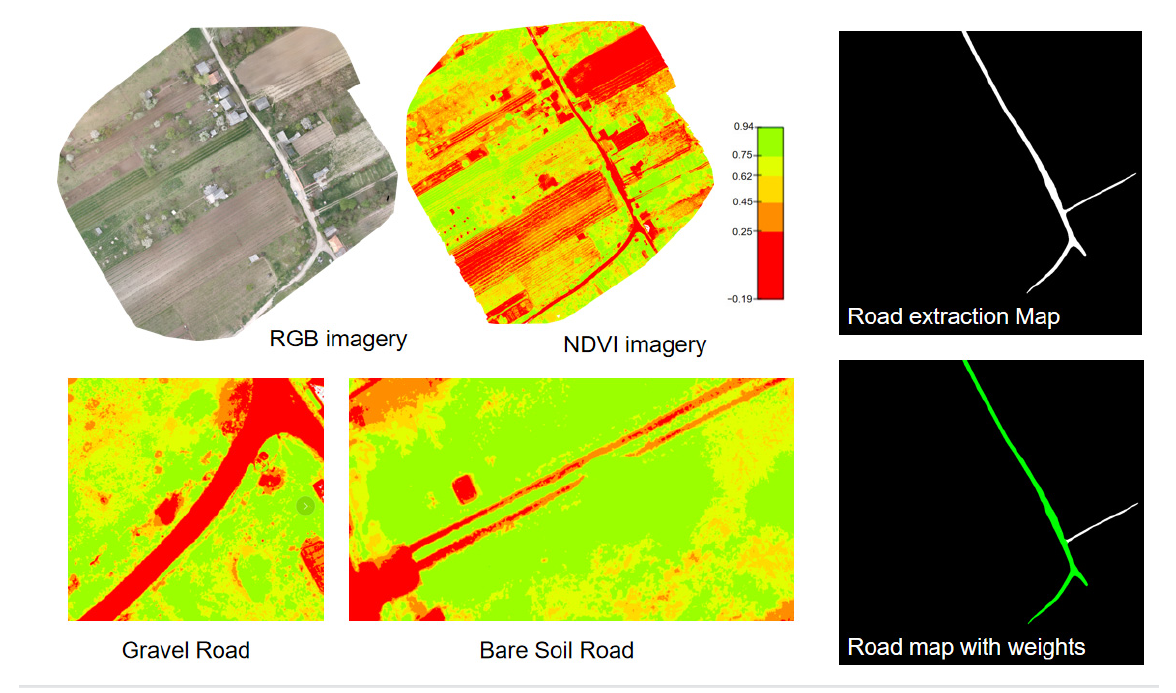
Figure 7. Road surface condition detection and road extraction with weights results for the UAV dataset.